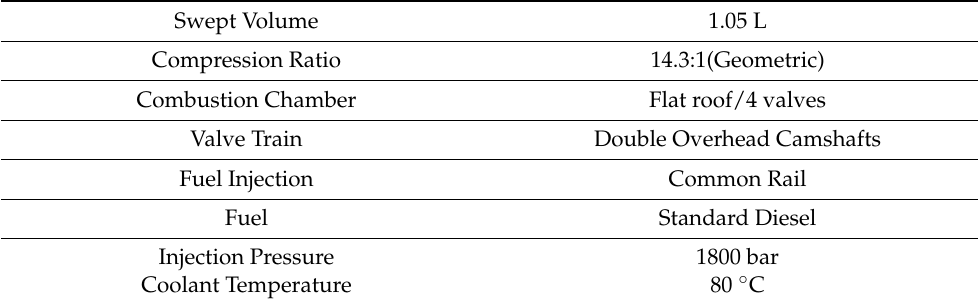
Table 1. Basic engine parameters.